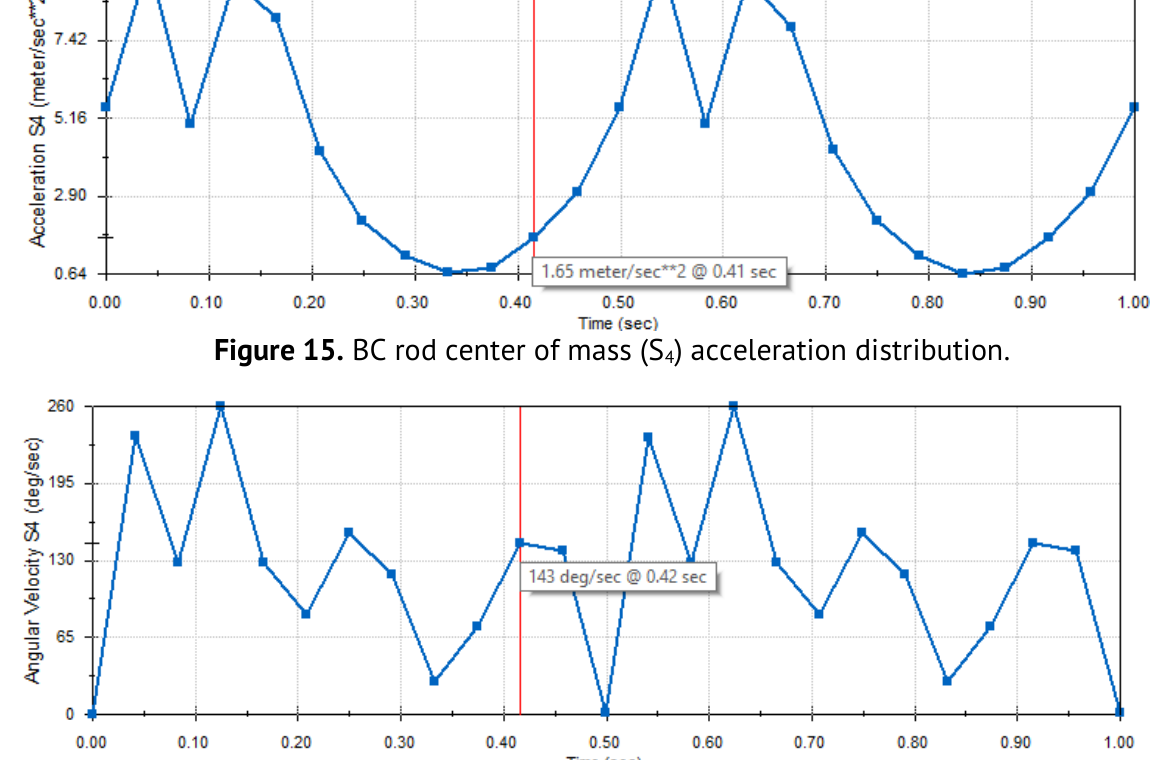
Figure 16. BC rod center of mass (S